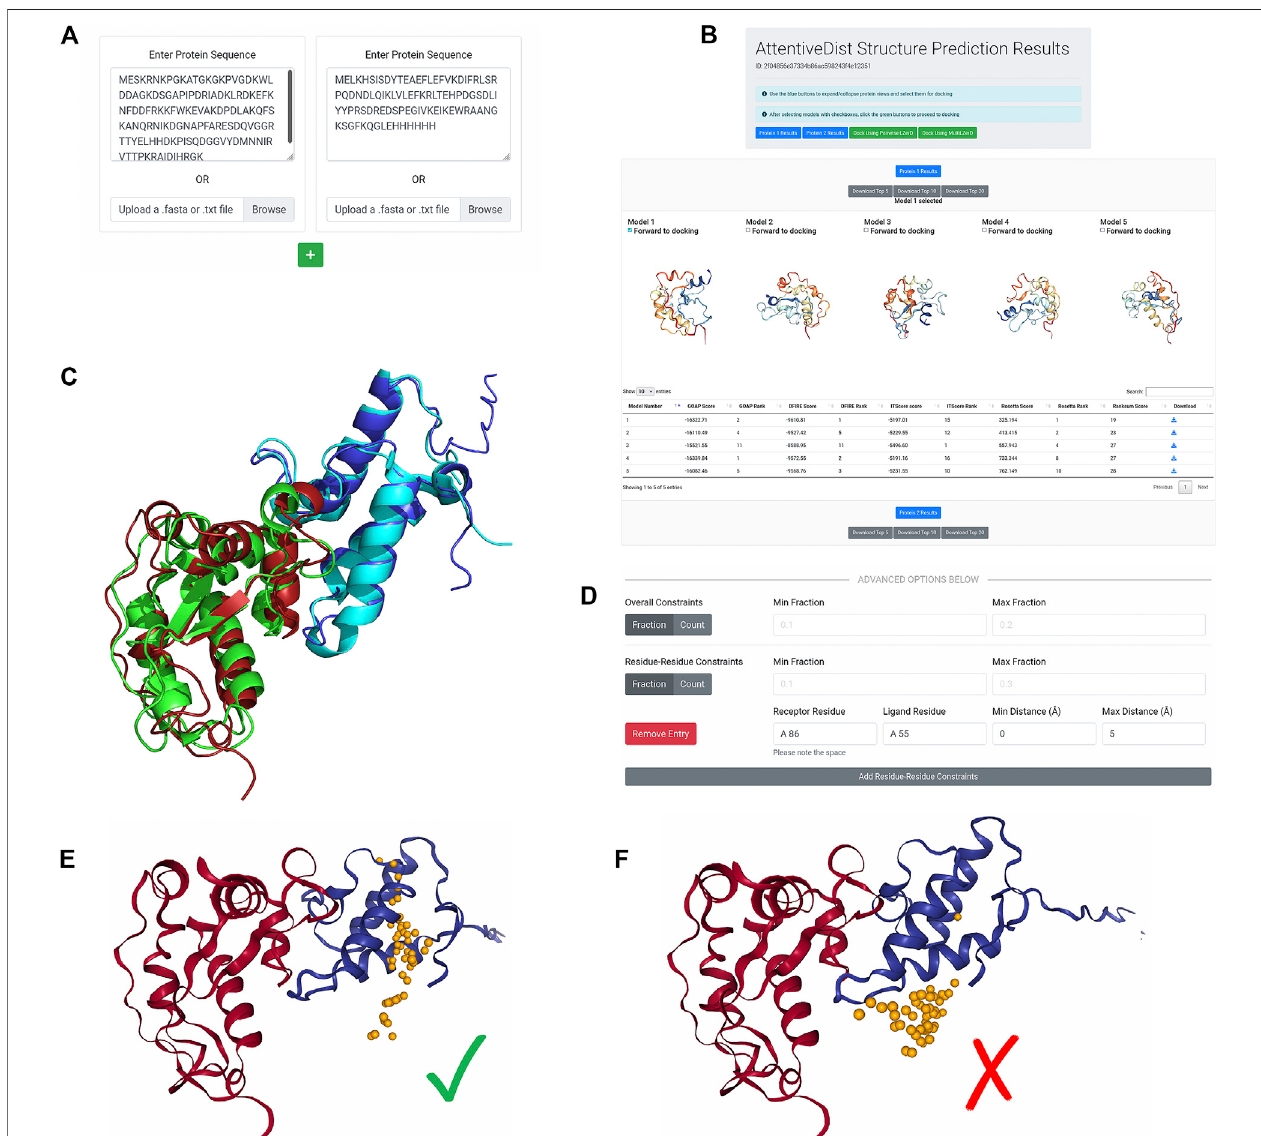
FIGURE 5 | De novo subunit modeling and LZerD docking of colEdes3:Imdes3. (A) The input for de novo modeling of the subunits with AttentiveDist. The sequences were pasted into the input fi elds, but users can alternatively upload FASTA fi les. (B) The results of de novo structure prediction. Both subunits are available from this page, and colEdes3 is currently selected for display. Users can download models individually or in bulk and can forward models to LZerD by selecting the checkboxes and clicking the LZerD or Multi-LZerD button. The scoring table appears below the 3D models. (C) The top-1 AttentiveDist models superimposed to thenativestructure(green andcyan;PDBID:6ERE).Thetop-1modelsforcolEdes3 (red)andImdes3(blue)haveRMSDsof2.5 Åand2.0Å. (D) Theconstraintusedfor LZerD docking. Here, Phe68 of colEdes3 was constrained to be in contact with Tyr55 of Imdes3 by specifying a distance cutoff of 5.0 Å. (E) Results of constrained LZerD. Model 5 is shown, and is of acceptable quality with an of 0.32, an I-RMSD of 3.9 Å, and an L-RMSD of 10.7 Å. As indicated by the centroid distribution, the dockingsearchhasbeen focusedaroundthebindingsitebytheconstraint.( F) ResultsofunconstrainedLZerD.Model13isshown,butisnotofacceptablequality, with an f nat of0.36,anI-RMSDof4.2 Å,andanL-RMSDof13.1 Å.ThisI-RMSDbarelymissedtheCAPRIthresholdforacceptablequality.Withoutanyconstraint,thedocking for this input does not produce acceptable models in the top 10. As indicated by the centroid distribution, the docked models are largely preferring a different